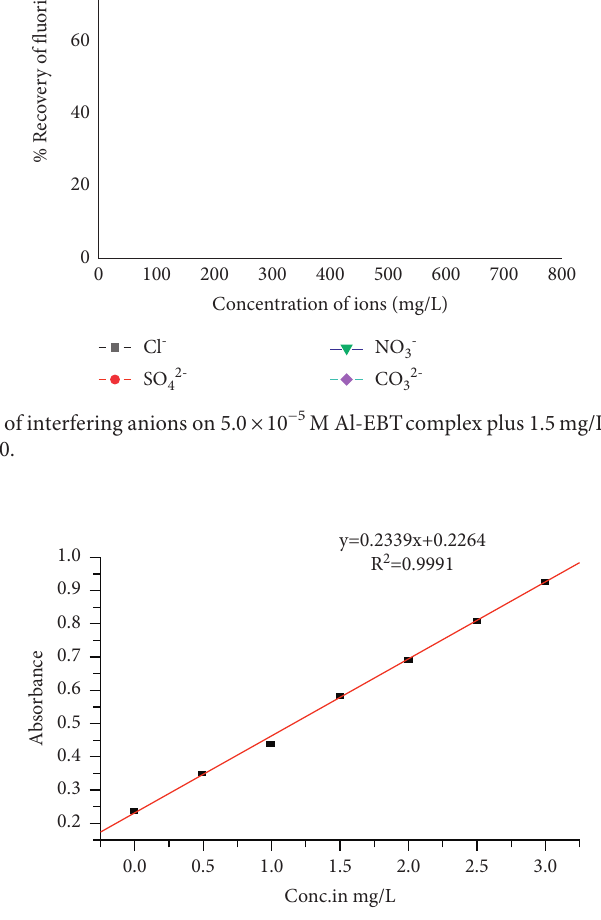
Figure 8: Calibration curve for the determination of fluoride at